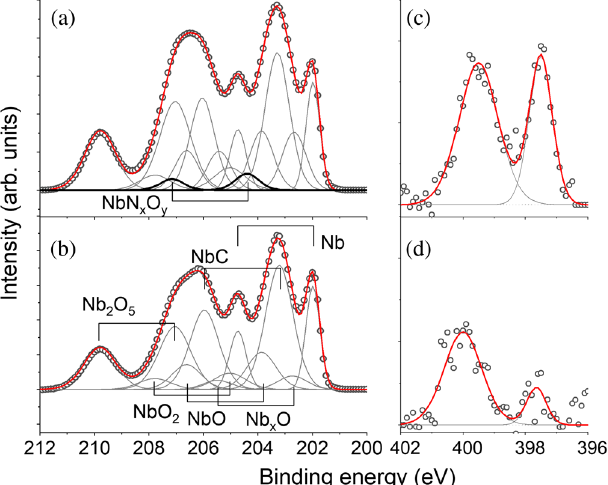
FIG. 8. Deconvolution of Nb 3d and N 1s lines in normal exit mode (a),(c) and with a 70° exit angle (b),(d). Phases correspond- ing to niobium, niobium oxides, and niobium carbides are represented in gray. Contributions from niobium nitrides are shown in